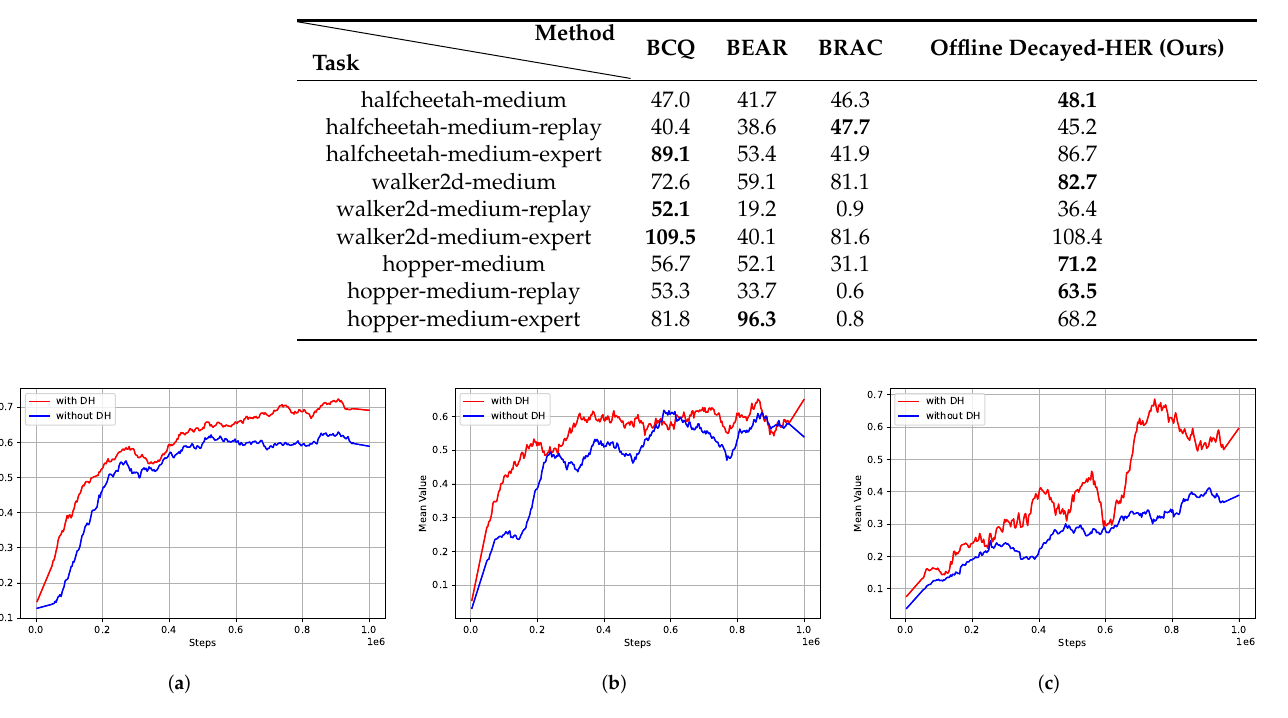
Table 7. Average normalized scores on D4RL benchmark tasks. The evaluations are averaged on 100 random seeds and normalized by following [54]. Our method shows promising results on the locomotion tasks.